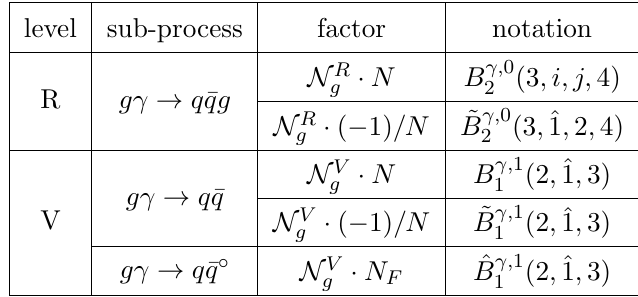
Table 3 . Summary of the gluon-channel partonic sub-processes and colour factors for the NLO calculation. The matrix element B (cid:13); 0 (3 ; i; j; 4) includes a summation f i; j g 2 P (^1 ; 2), where ^1 is 2 the initial-state gluon. Each (cid:14) denotes a closed quark